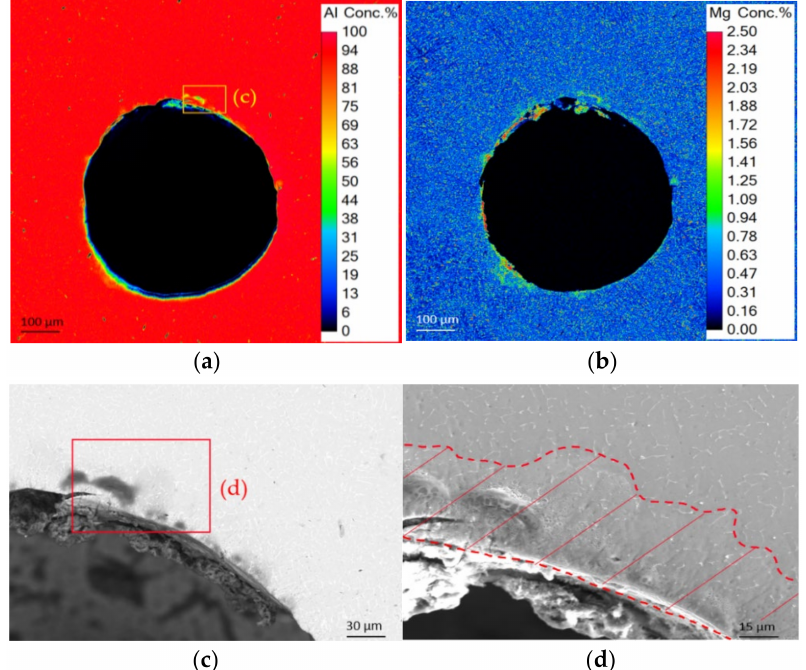
Figure 8. Elemental mapping in the area of a pore of ( a ) aluminum and ( b ) magnesium; ( c ) BSE image of pore edge; ( d ) SE image with highlighted foamy Mg-rich